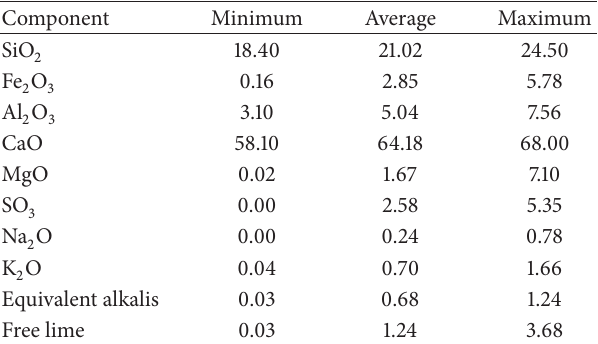
Table 1: Summary of chemical data for a selection of Portland